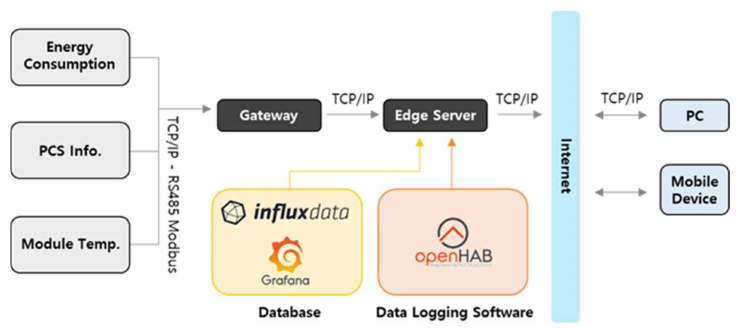
Figure 5. Schematic diagram of the remote monitoring